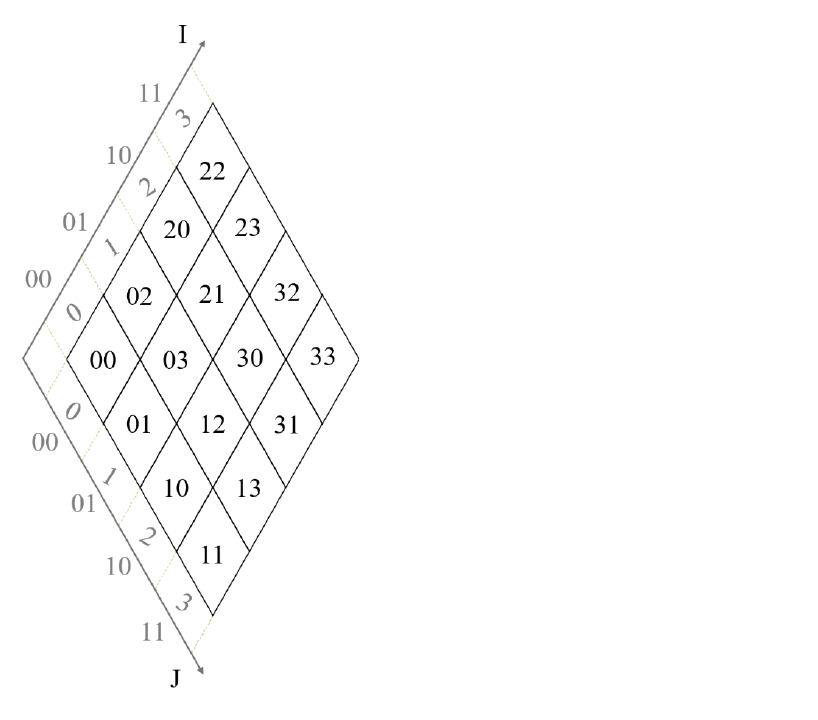
Figure 19. Linear quadtree encoding based on Morton encoding coordinate System.